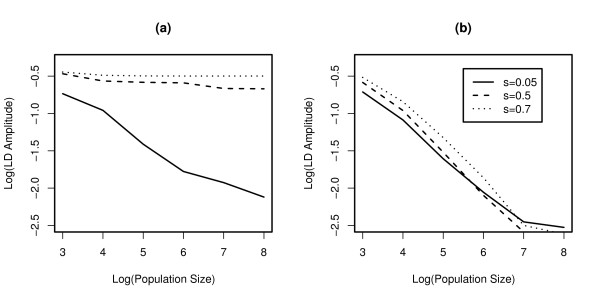
The effect of population size N on the amplitude of LD oscillations in the standard model (a) and in the sequential-updating model (b). The amplitude of the LD oscillations is measured as the maximum difference of linkage disequilibrium (ΔLD) between t = 10 000 and t = 20 000. The following parameter was used: rmm = 0.1.